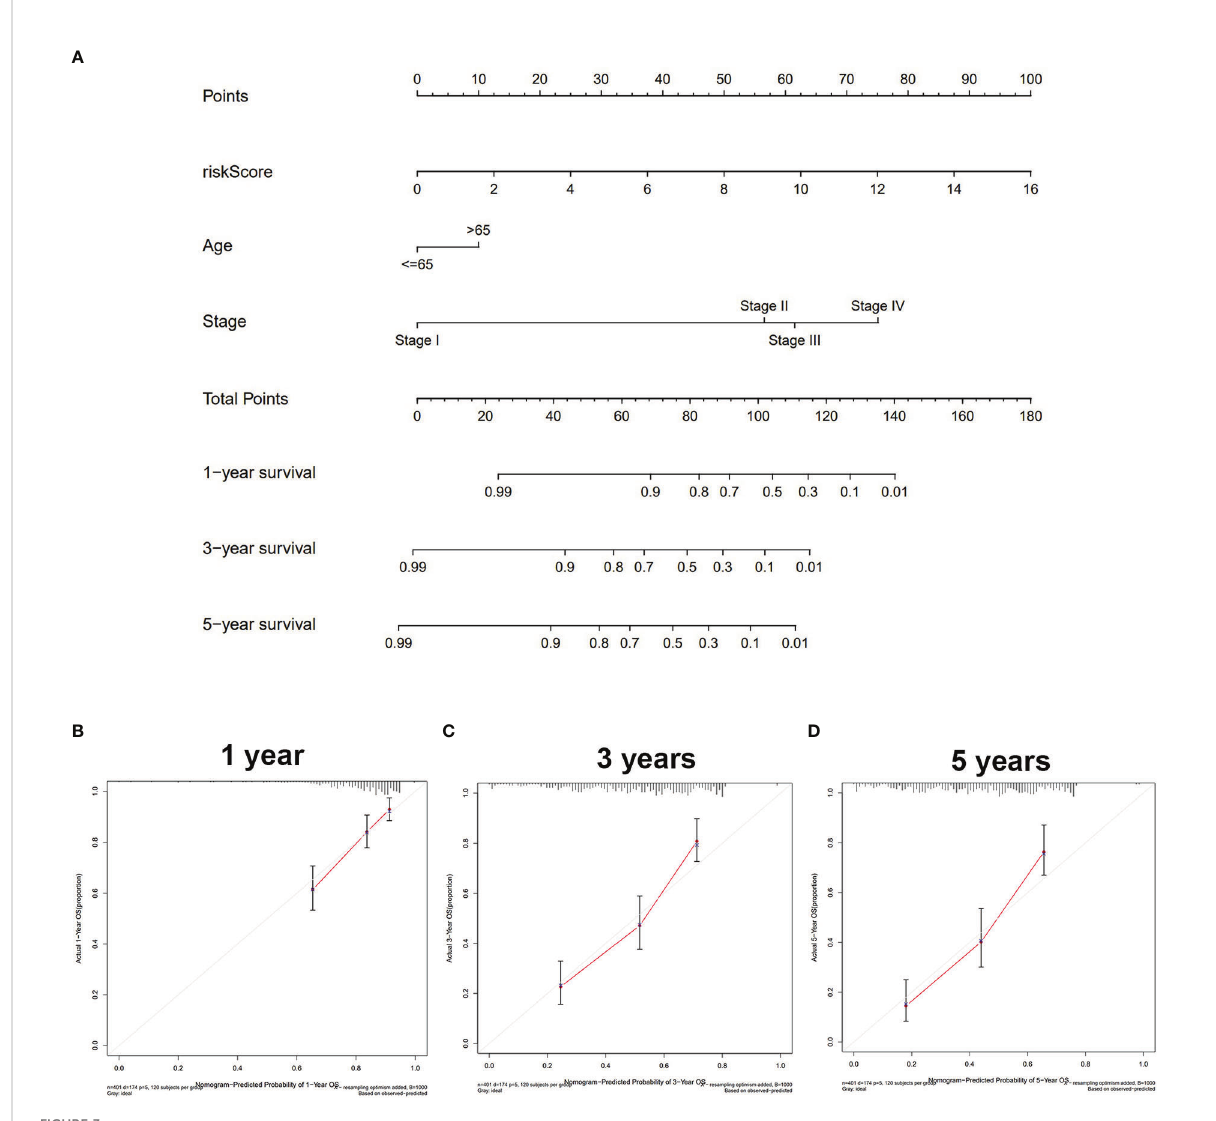
FIGURE 3 Construction and validation of the nomogram. (A) The nomogram based on riskScore, age, and stage to predict the 1-, 3-, and 5-year survival in BLCA patients. (B) One-year nomogram calibration. (C) Three-year nomogram calibration. (D) Five-year nomogram calibration. BLCA, bladder